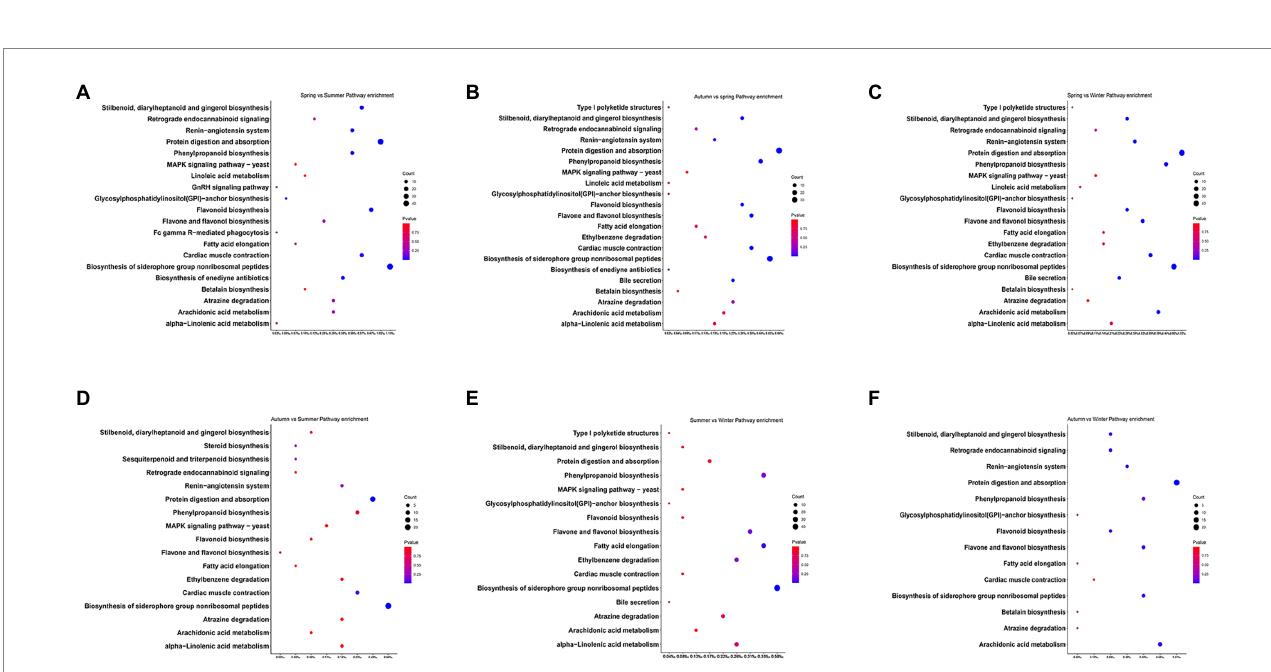
FIGURE 5 Analysis of KEGG annotation in groups with significant differences in macronutrient intakes to predict the function of gut microbial, including spring vs. summer group (A) , autumn vs. spring group (B) , spring vs. winter (C) , autumn vs. summer (D) , summer vs. winter group (E) , and autumn vs. winter (F)